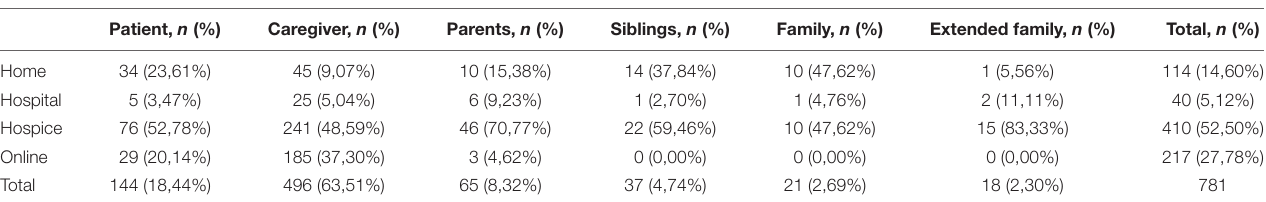
TABLE 3 | Psychological sessions